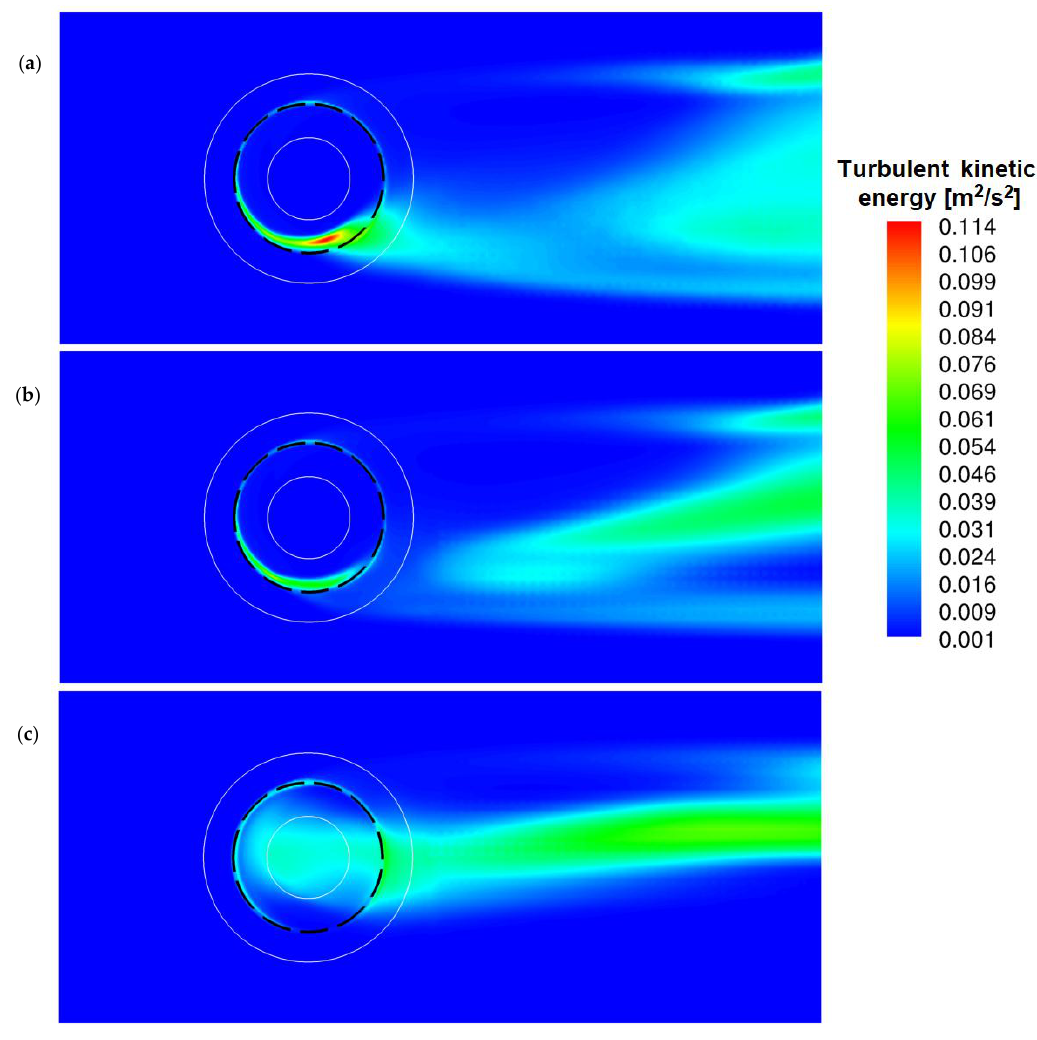
Figure 15. Average turbulent kinetic energy field in three horizontal planes: ( a ) y / H = 0.1, ( b ) y / H = 0.5, ( c ) y / H = 1.0. The dashed black line represents the circle described by the blades chord and the solid white lines delimitate the inner and outer boundaries of the rotating ring. Flow is from left to right.